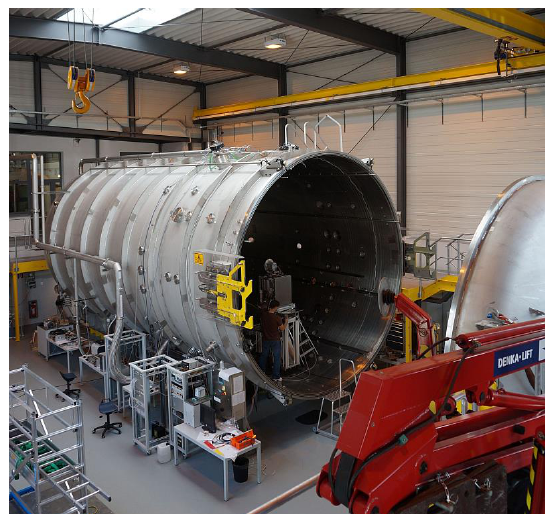
Figure 1: View into the open vacuum chamber of the STG-ET